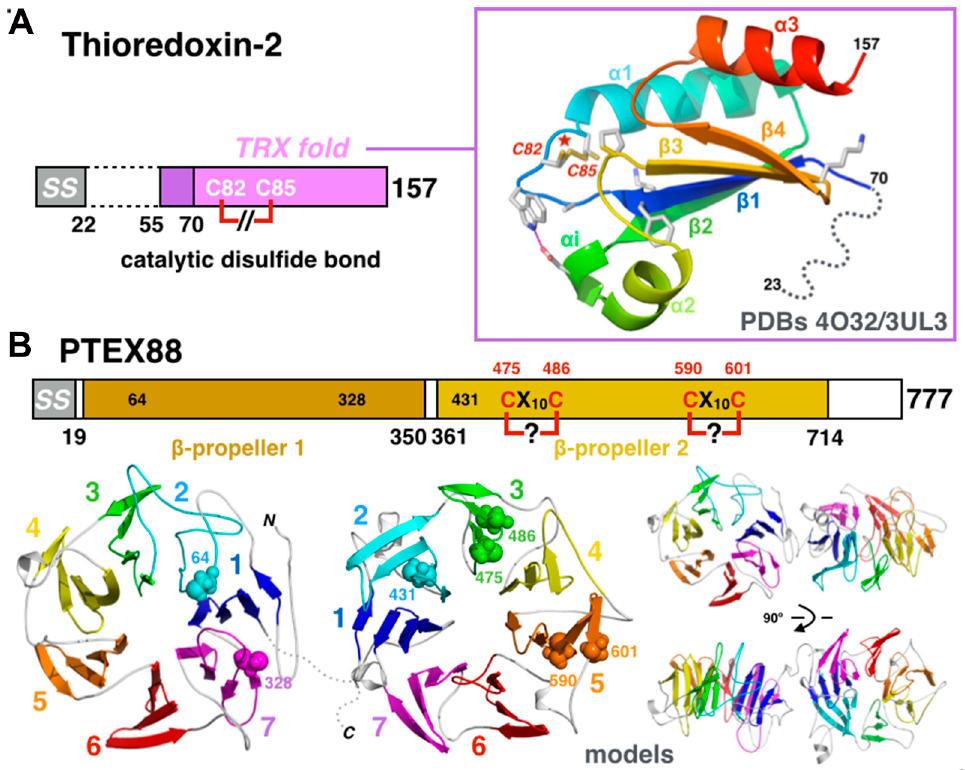
Figure 8 . Accessory proteins TRX2 and PTEX88. ( A ) Crystal structure of the Plasmodium thioredoxin-2. The C 82 XXC 85 catalytic dyad residues (marked with a star) are shown in the reduced and oxidized forms simultaneously observed in the crystal [86] . ( B ) Homology model of the Plasmodium protein PTEX88. The homology model of PTEX88 suggests the presence of two seven-bladed β -propeller domains shown, with each blade colored using a rainbow pattern with a disulfide bond in the predicted C 590 X 10 C 601 motif of the C- terminal propeller. The unknown relative orientation between the two propellers domains is thought to be important in defining the functional protein interfaces.